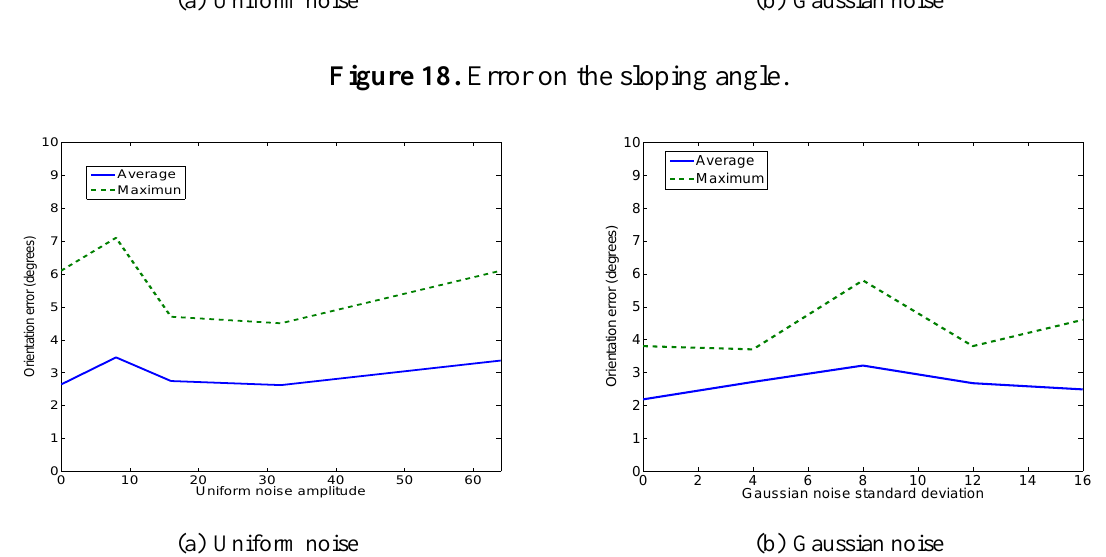
Figure 18. Error on the sloping angle.